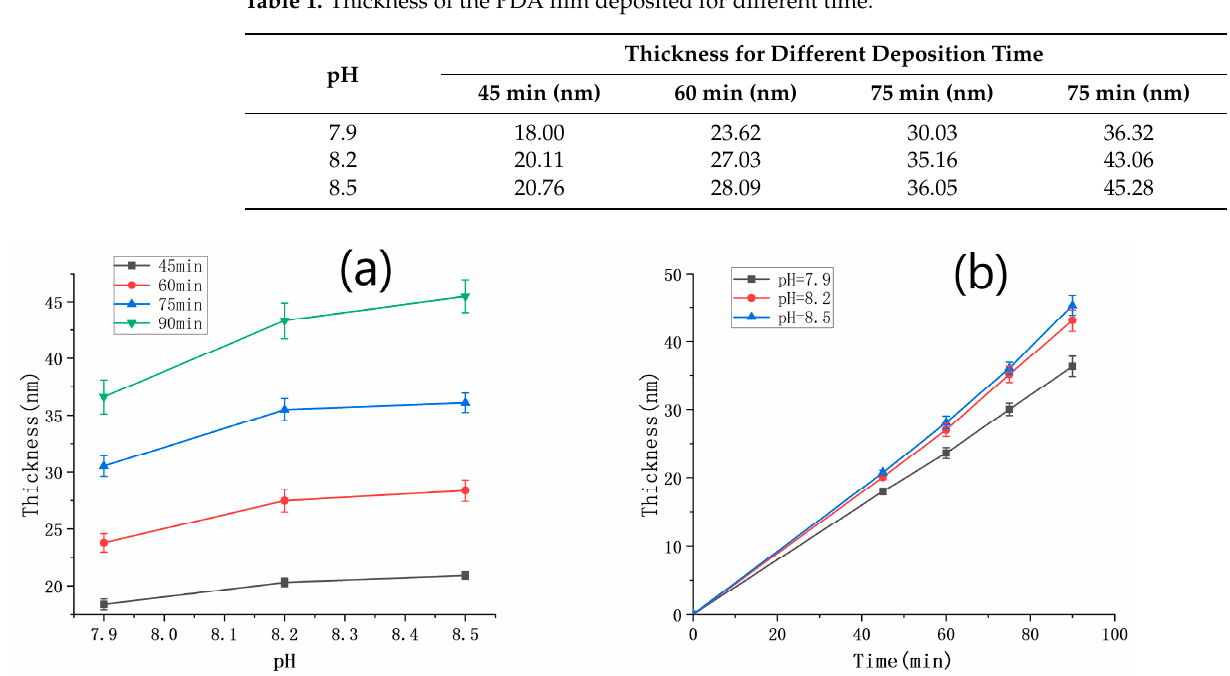
Figure 2. SEM images of the cross section of the PDA films on silicon dioxide substrates deposited for 60 min under the conditions of ( a ) pH = 7.9, ( b ) pH = 8.2 and ( c ) pH = 8.5; SEM images of the cross section of the PDA films on silicon dioxide substrates deposited for 90 min, with ( d ) pH = 7.9, ( e ) pH = 8.2 and ( f ) pH = 8.5. Table 1. Thickness of the PDA film deposited for different time.